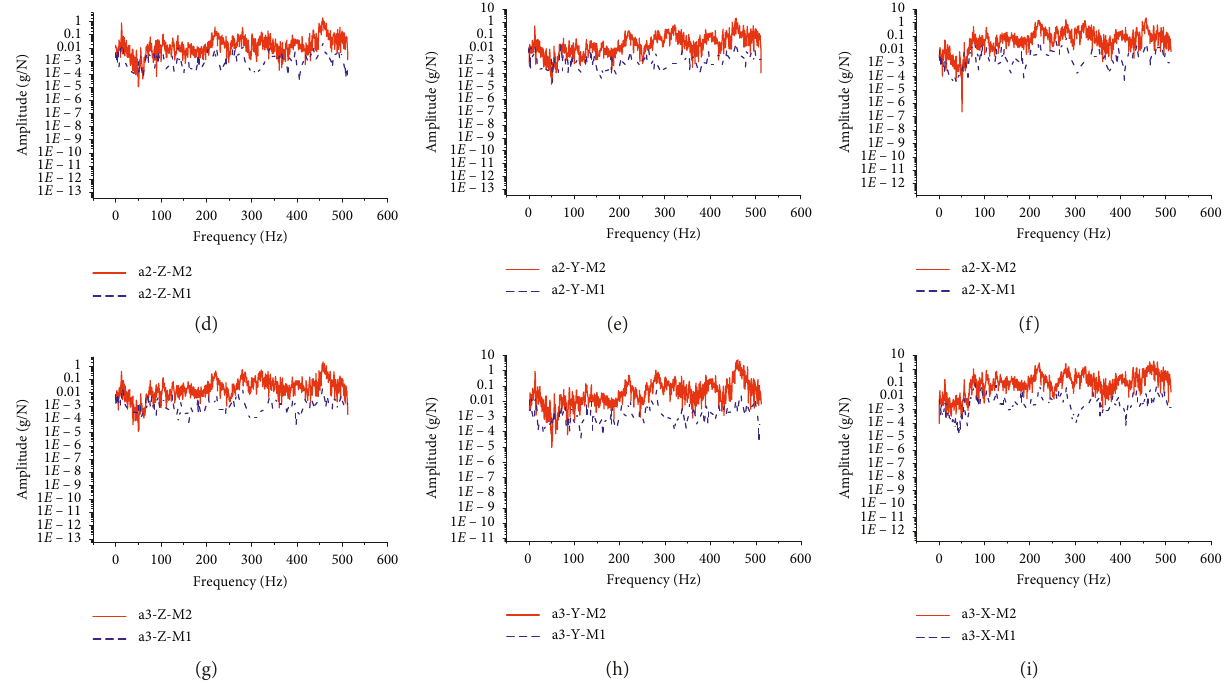
Figure 11:10–12s time section, point O ( a )3( ω ) , in the Z direction. Nine paths of { H s,c ( a ) c ( b ) ( ω ) 6 } calculated using M-2 compared to nine static paths of { H s,c ( a ) c ( b ) ( ω )} calculated using M-1; a n represents the path of C ( a ) n ( ω ) in the Z